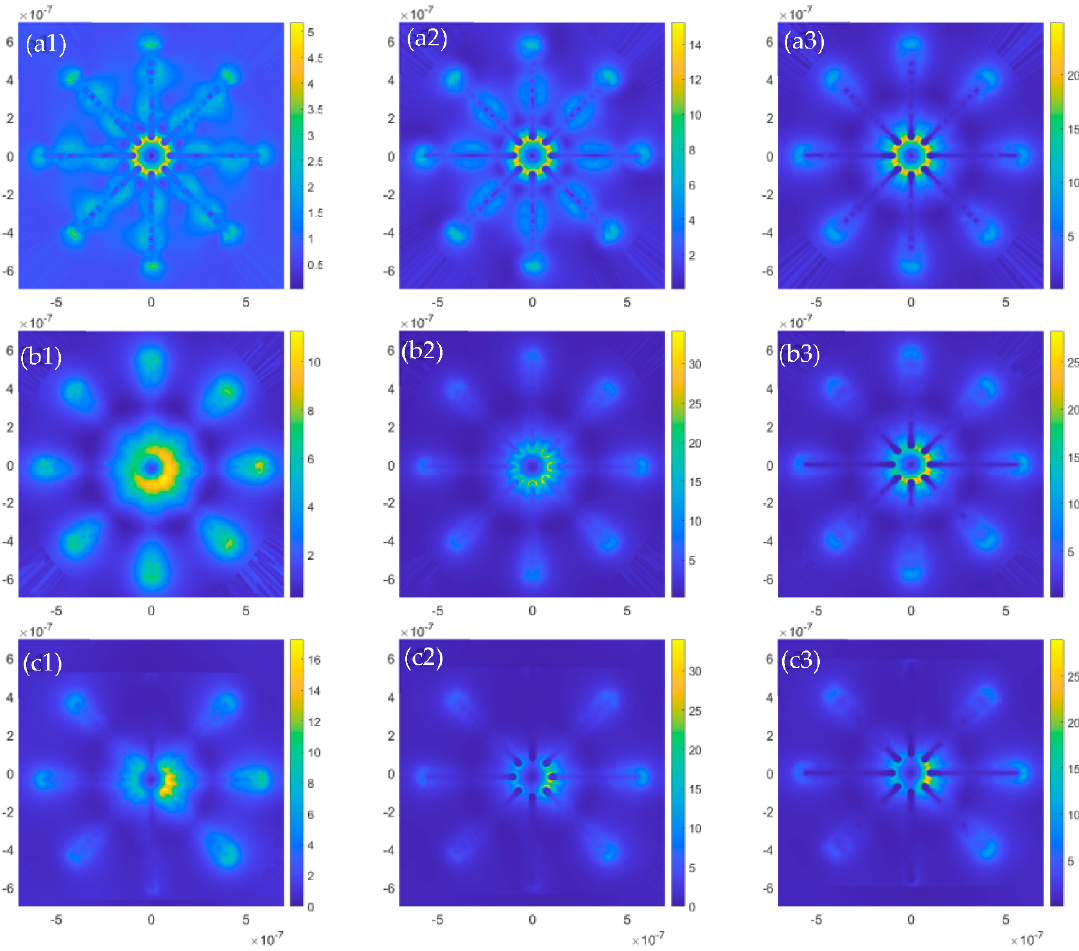
Figure 7. ( a ) Gain field for a beam at normal incidence to the antenna with an (LG) m = 1 at 600 nm, 850 nm, and 1800 nm wavelength excitation, for labels a1, a2, and a3, respectively. ( b ) Gain field for incidence at 22.5° to the antenna at 1800 nm wavelength excitation at 50 nm, 30 nm, and 0 nm over the antenna plane for labels b1, b2, and b3, respectively. ( c ) Gain field with an incident beam (LG) m = 1 at 45° to the antenna at 1800 nm wavelength excitation at 50 nm, 30 nm, and 0 nm over the antenna plane for labels c1, c2, and c3, respectively.